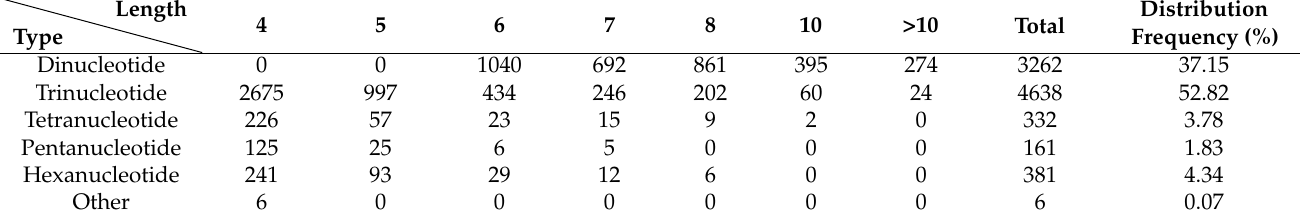
Table 1. The length and distribution frequency of simple sequence repeat (SSR) types in H. macrophylla